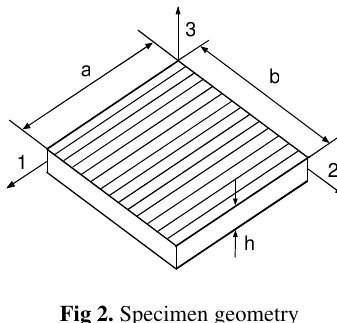
Fig 2. Specimen geometry